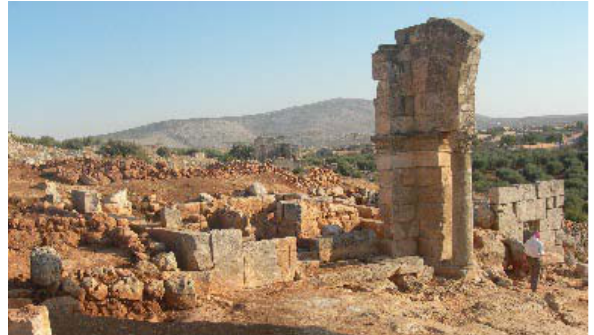
Figure 11. The high definition survey of the top block of the baptistery basin and the used scanner.